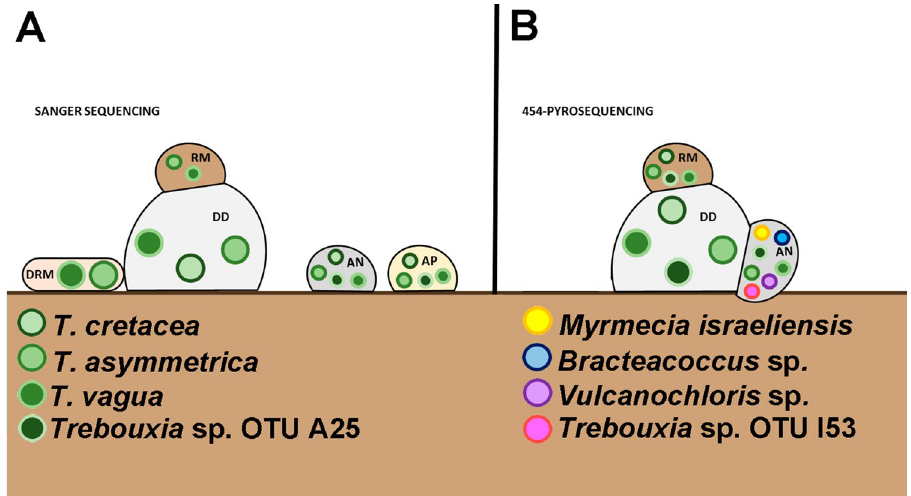
Figure 3. ( A ) Summary of the Trebouxia phycobiont diversity detected by Sanger sequencing in Diploschistes diacapsis (DD), Acarospora nodulosa (AN), A. placodiiformis (AP), Rhizocarpon malenconianum (RM) and Diplotomma rivas-martinezii (DRM). A total of four Trebouxia spp. were detected, namely, T. asymmetrica , T. vagua , T. cretacea and Trebouxia sp. OTU A25, each of which is shown as a different green circle. ( B ) Depiction of the microalgae detected by 454-pyrosequencing in three specimens of Diploschistes diacapsis (DD), Acarospora nodulosa (AN) and Rhizocarpon malenconianum (RM). Each microalgal strain detected is indicated with a coloured circle.